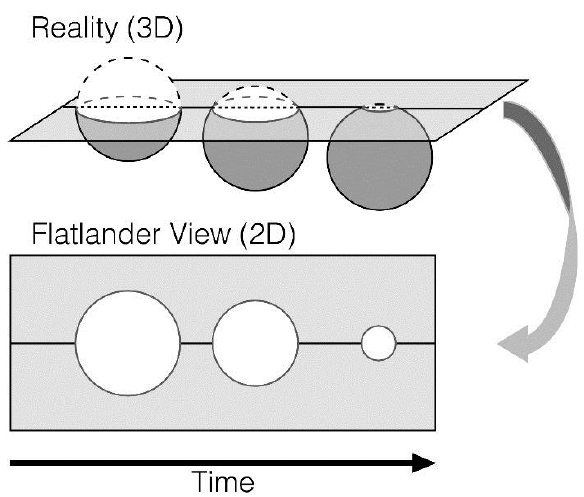
Figure 1. A. Square cannot perceive his world as anything other than two dimensional. (Reprinted by permission of the publisher).